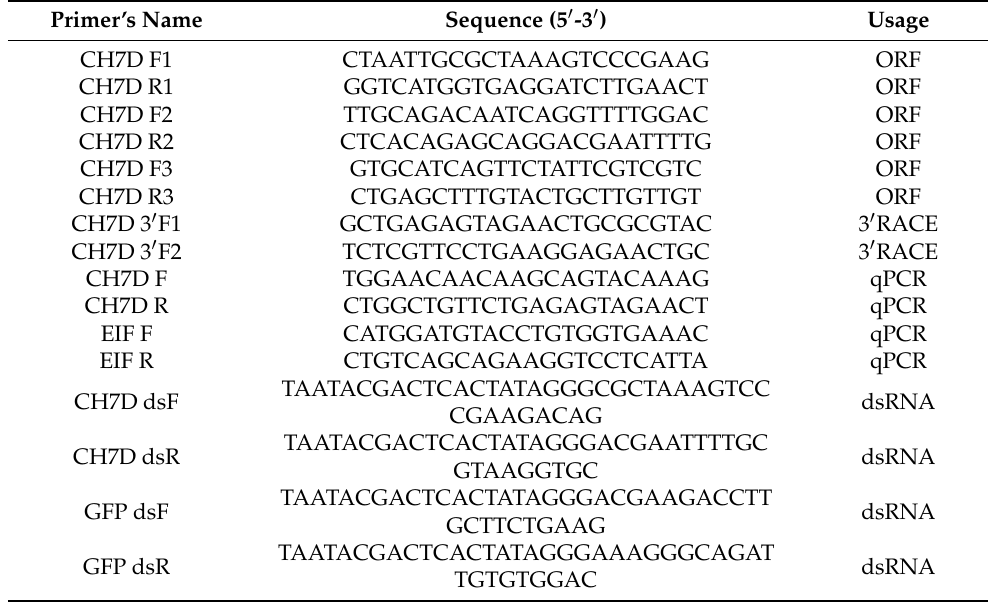
Table 2. Primers for cDNA clone, qPCR analysis, and RNAi involved in this